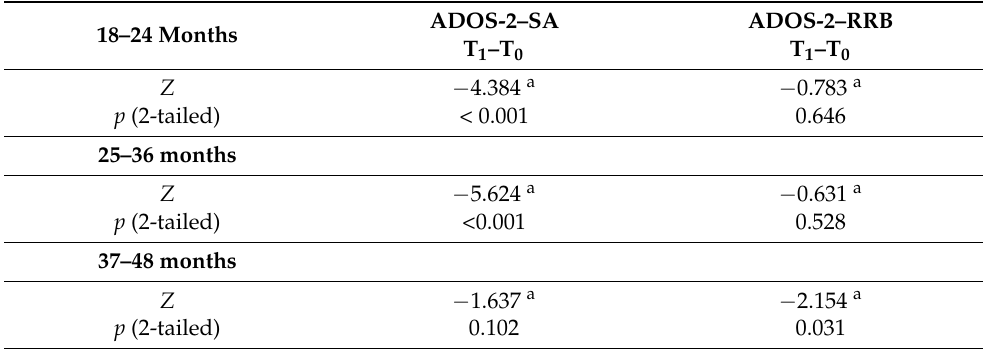
Table 7. Wilcoxon Signed Ranks Test applied to ADOS-2 SA and RRB sub-scores at T 0 and T 1 for each age class (18–24, 25–36, and 37–48 months at the first consultation).